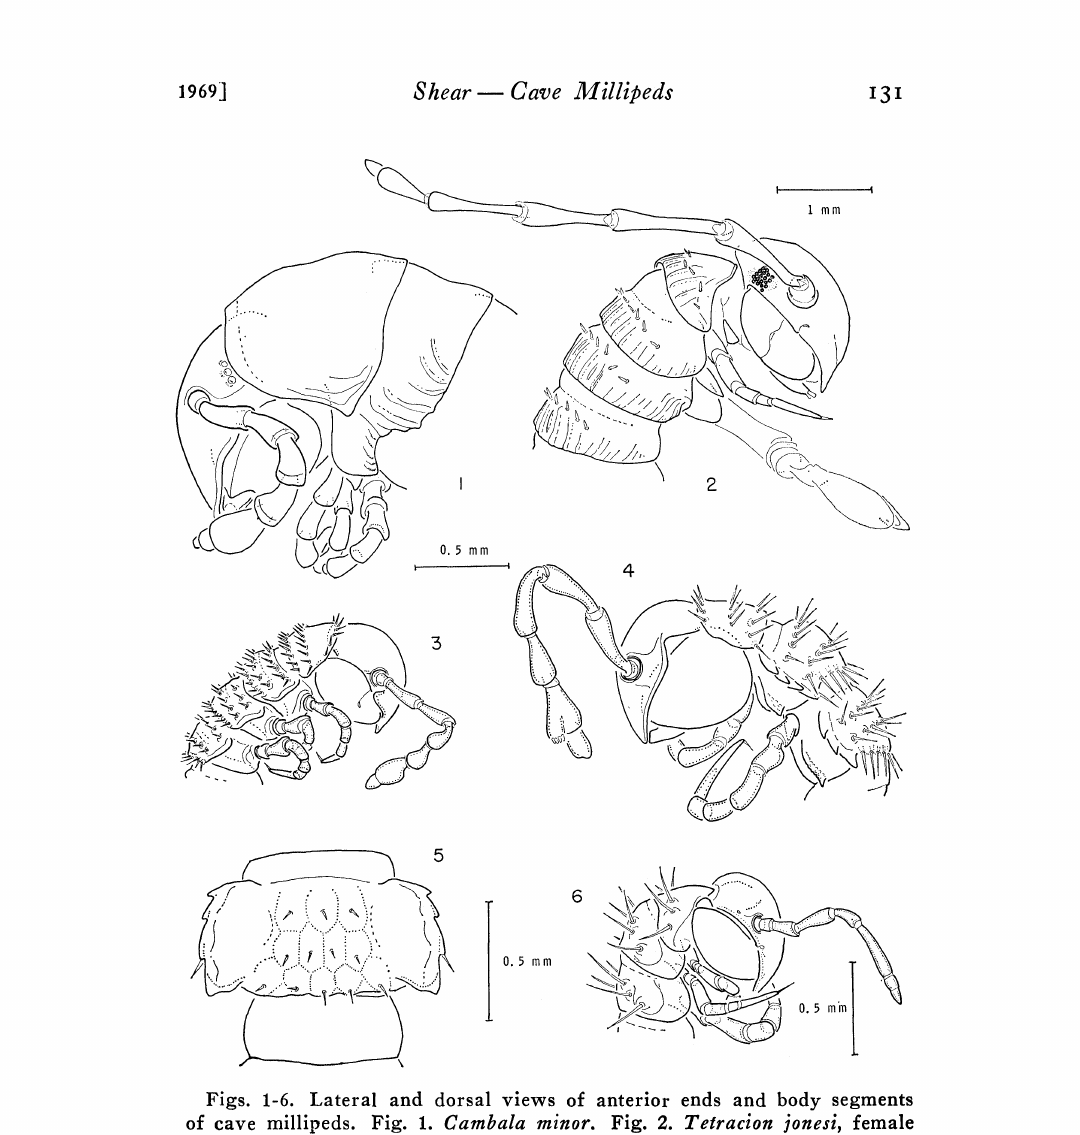
Figs. 1-6. Lateral and dorsal views of anterior ends and body segments of cave millipeds. Fig. 1. Cambala minor. Fig. 2. Tetracion jonesi, female with ovipositor. Fig. 3. I ntriadesmus [ragilis. Fig. 4. Seodesmus echi- nourus. Fig. 5. Dorsal view of midbody segment of Brachydesmus suerus. Fig. 6. Zygonokus